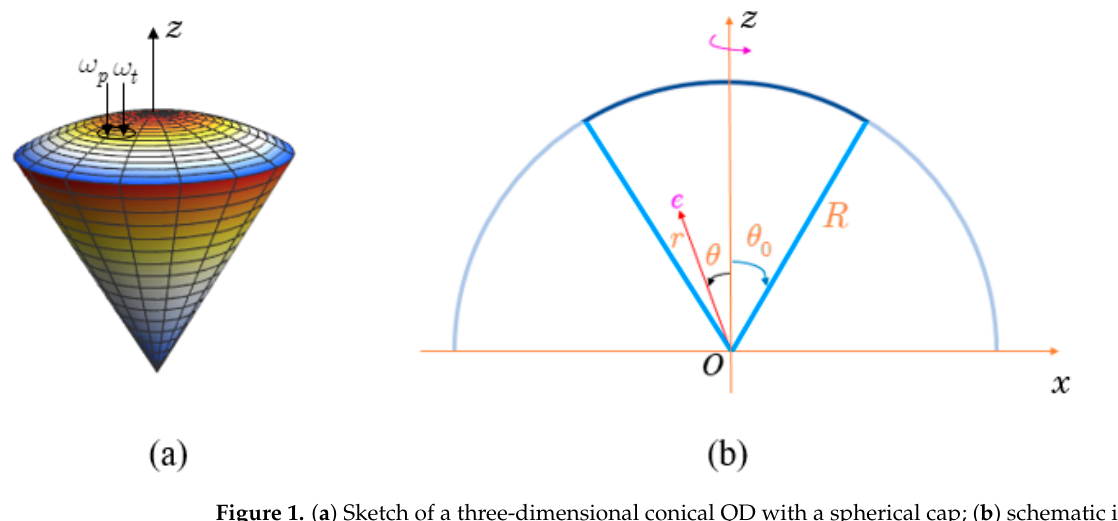
Figure 1. ( a ) Sketch of a three-dimensional conical QD with a spherical cap; ( b ) schematic image of the conical QD with a spherical cap, in the y = 0 projection [28].